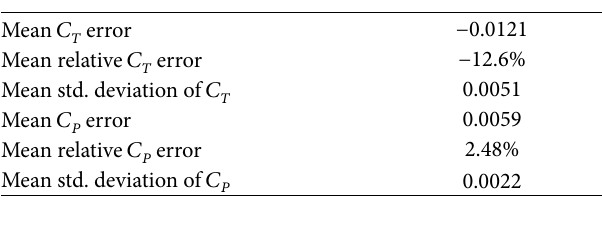
Table 3: Errors between measured and simulated propeller charac- teristics—thrust coefficient ( 𝐶